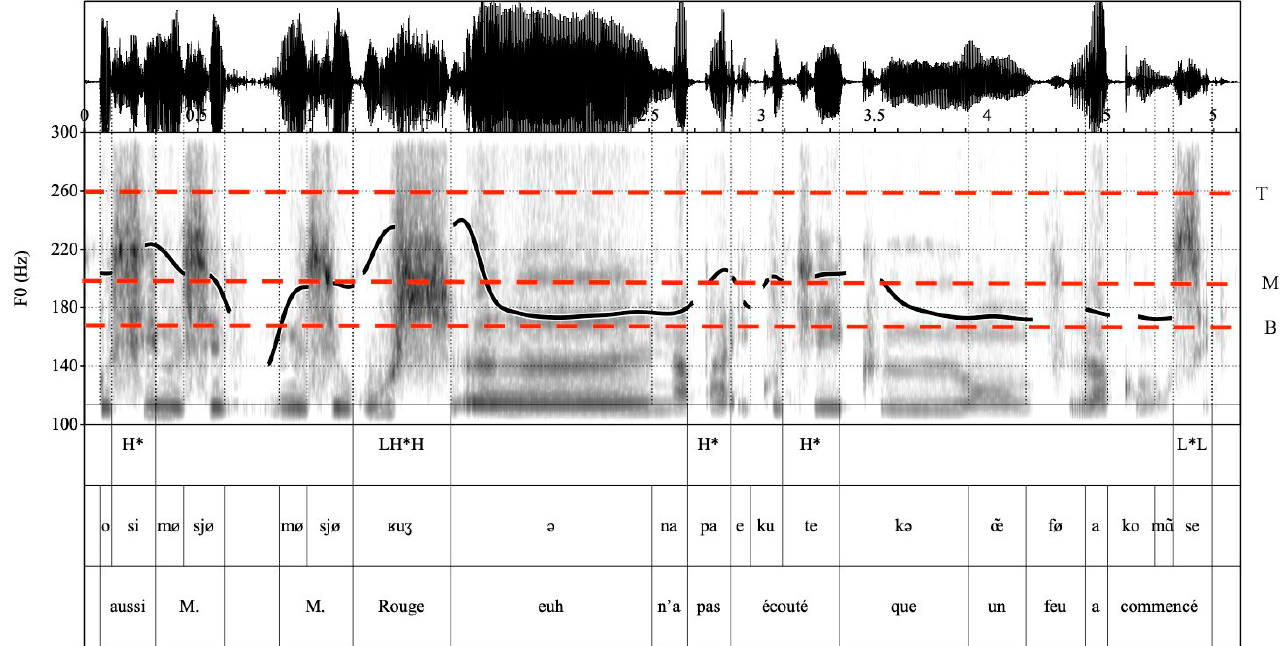
Figure 9. Additive utterance in French L2 with postfinite aussi (25-INT sbj01). Accented syllables are indicated with *.